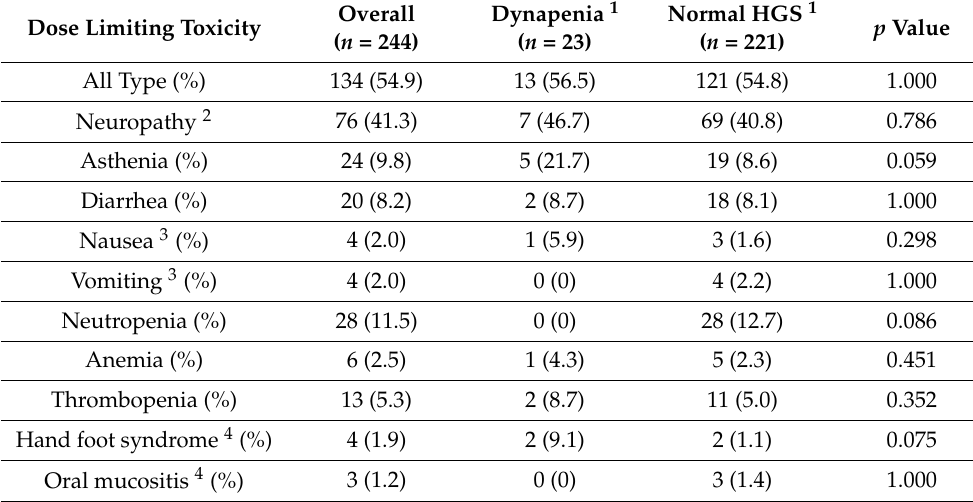
Table 2. Association between dynapenia (original EWGSOP2 criteria) and chemotherapy-induced dose-limiting toxicity